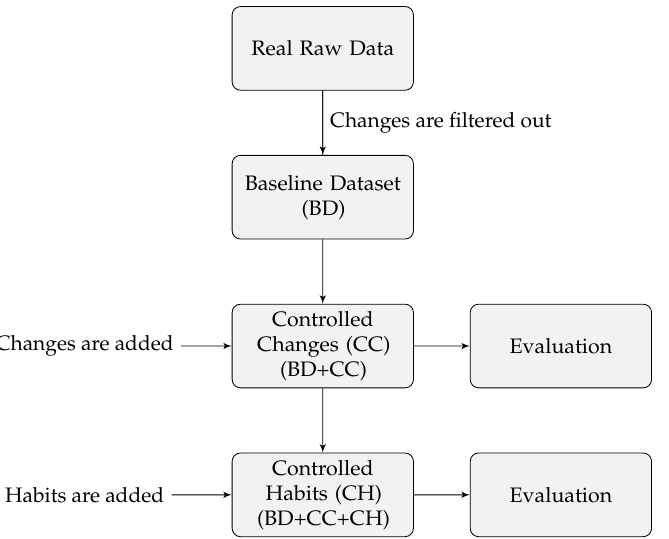
Figure 4. Method to evaluate U-BEHAVED accuracy in detecting behaviour changes and habits